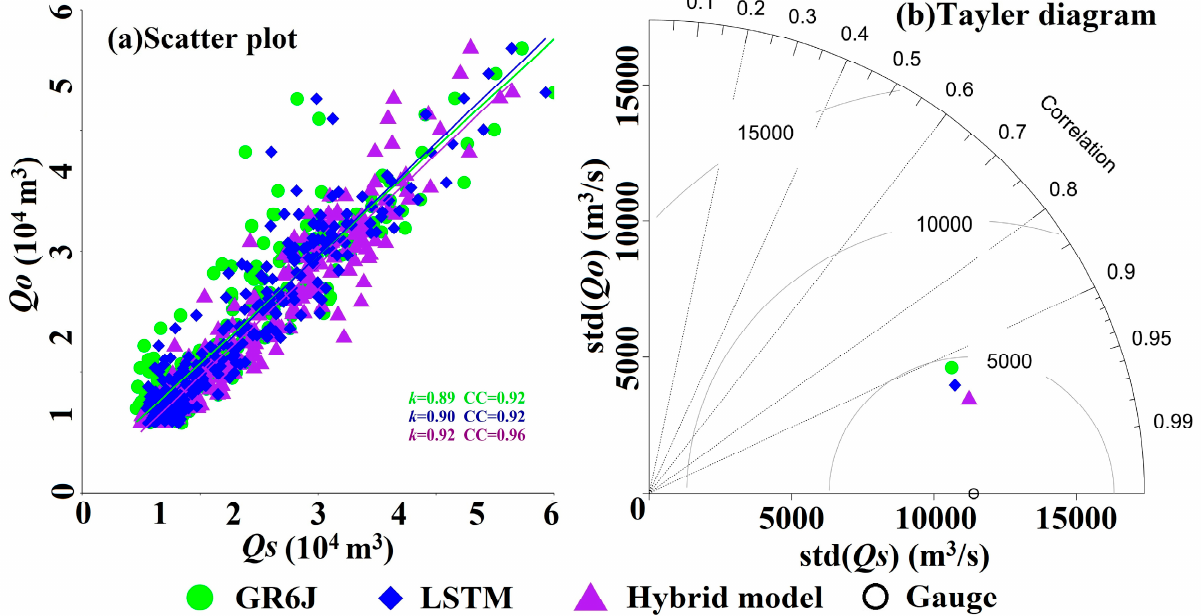
Figure 8. ( a ) Scatter plots and ( b ) Tayler diagram between estimated flow discharges by the GR6J, LSTM and hybrid models at the VS077, and observed flow discharges at the Huangshigang station during 2009–2016. Note: The green, blue, and purple lines in subfigure ( a ) indicate the fitted linear regression lines between estimated flow discharges by the GR6J, LSTM, and hybrid models, and observed flow discharges.